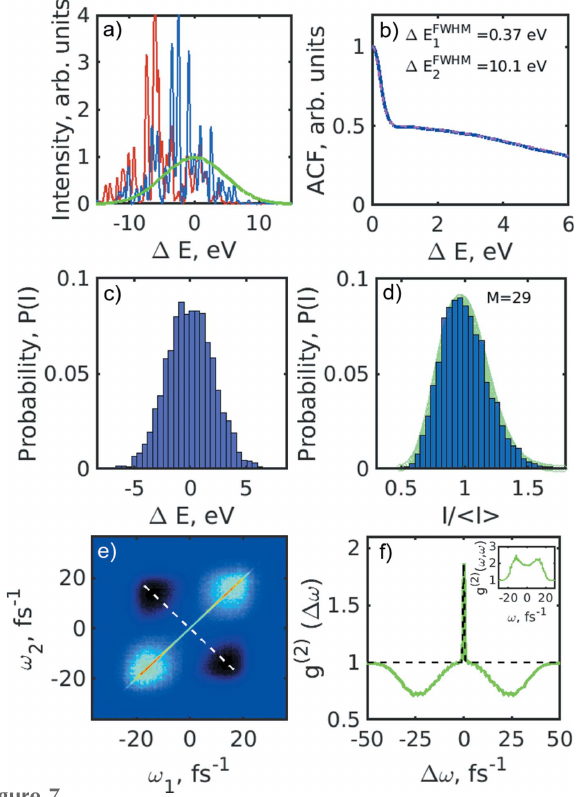
Figure 7 Spectral analysis simulation with a resonant energy jitter of 5 eV (FWHM). ( a ) Typical single-shot simulated spectra and an averaged spectrum (green line). ( b ) Autocorrelation function of the individual spectral lines averaged over 5 (cid:4) 10 3 pulses (blue solid line) and the fit with the two Gaussian functions (magenta dashed line). ( c ) Histogram of the resonant energy distribution. ( d ) Histogram of the spectral pulse intensity distribution (blue). The green background corresponds to the gamma probability distribution function with number of modes M = 29. ( e ) Second-order intensity correlation function g (2) ( ! 1 , ! 2 ) of the simulated spectra. ( f ) Second-order intensity correlation function g (2) ( (cid:2) ! ) taken along the white dashed line in ( c ) and its fit (black dashed line) with equation (9). In the inset the profile of the g (2) ( ! , ! ) function along the diagonal in ( e ) is shown.